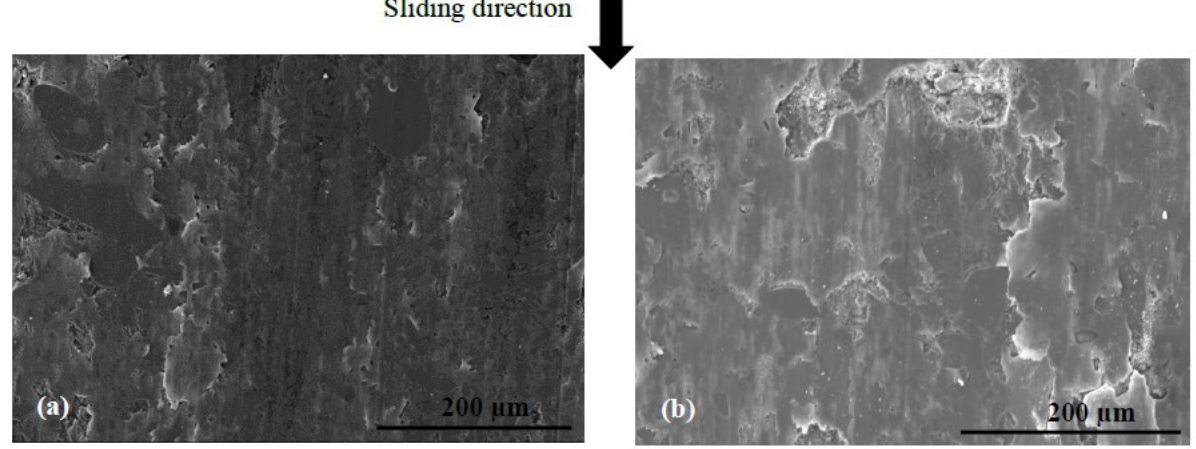
Figure 17. Secondary plateaus revealed in the rubbed surfaces of ( a ) M1 and ( b ) M2 (SEM, SE).